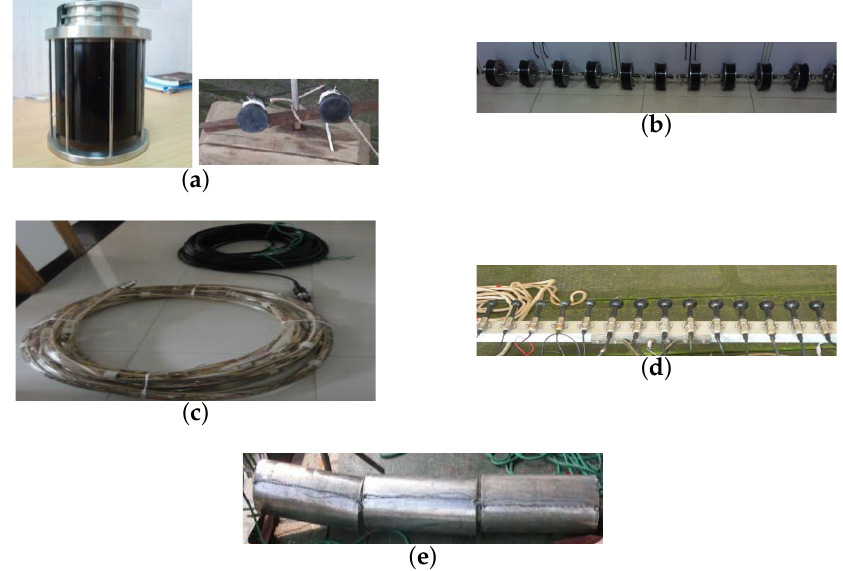
Figure 7. ( a ) probe source (left) and 2-element transmitting array (right); ( b ) 8-element time-reversal array; ( c ) 16-element vertical receiving array for recording time-reversed signals; ( d ) 14-element horizontal array for receiving target echoes; ( e )